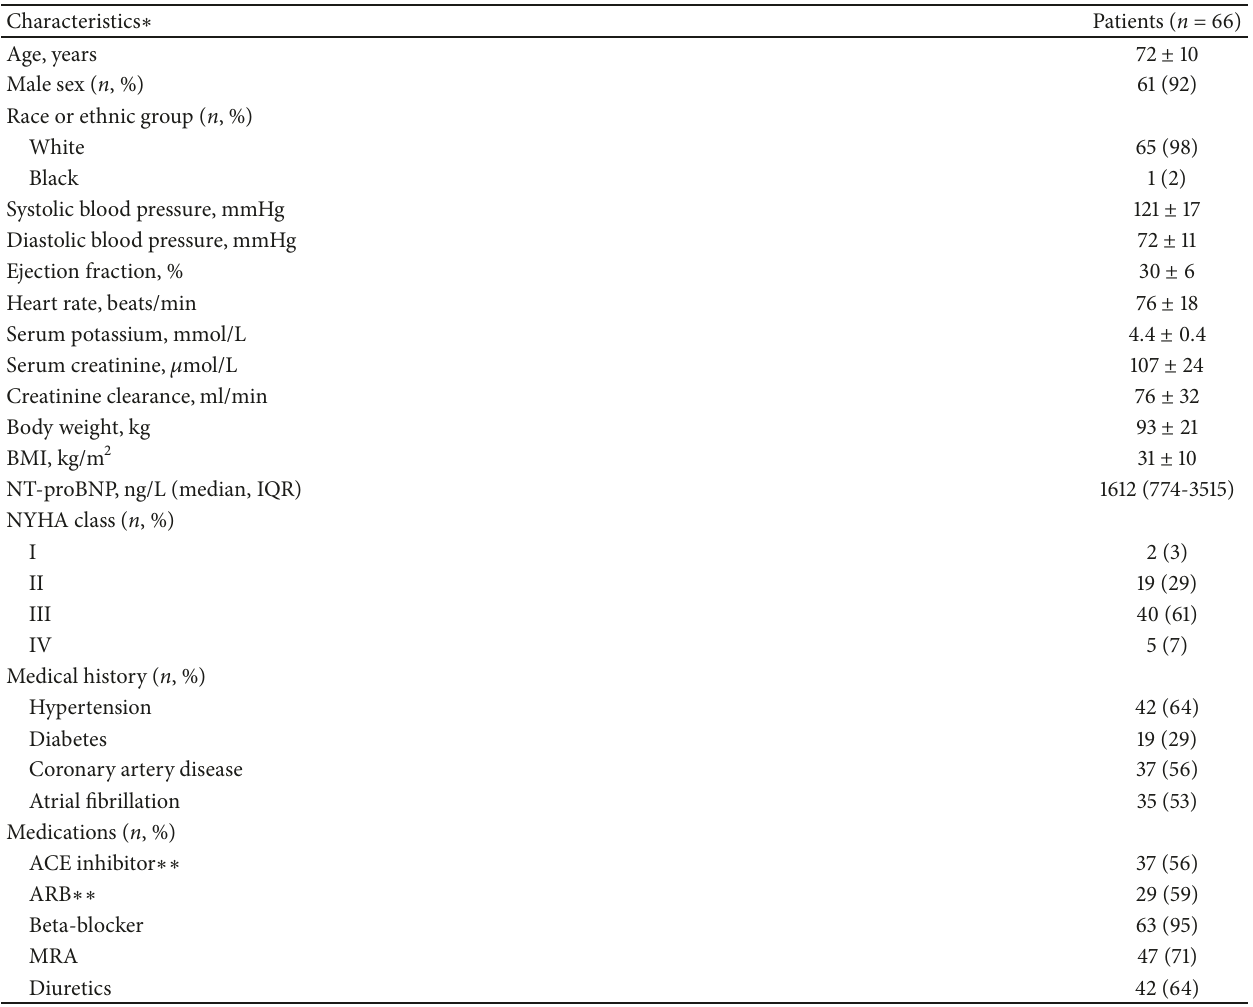
Table 1: Baseline